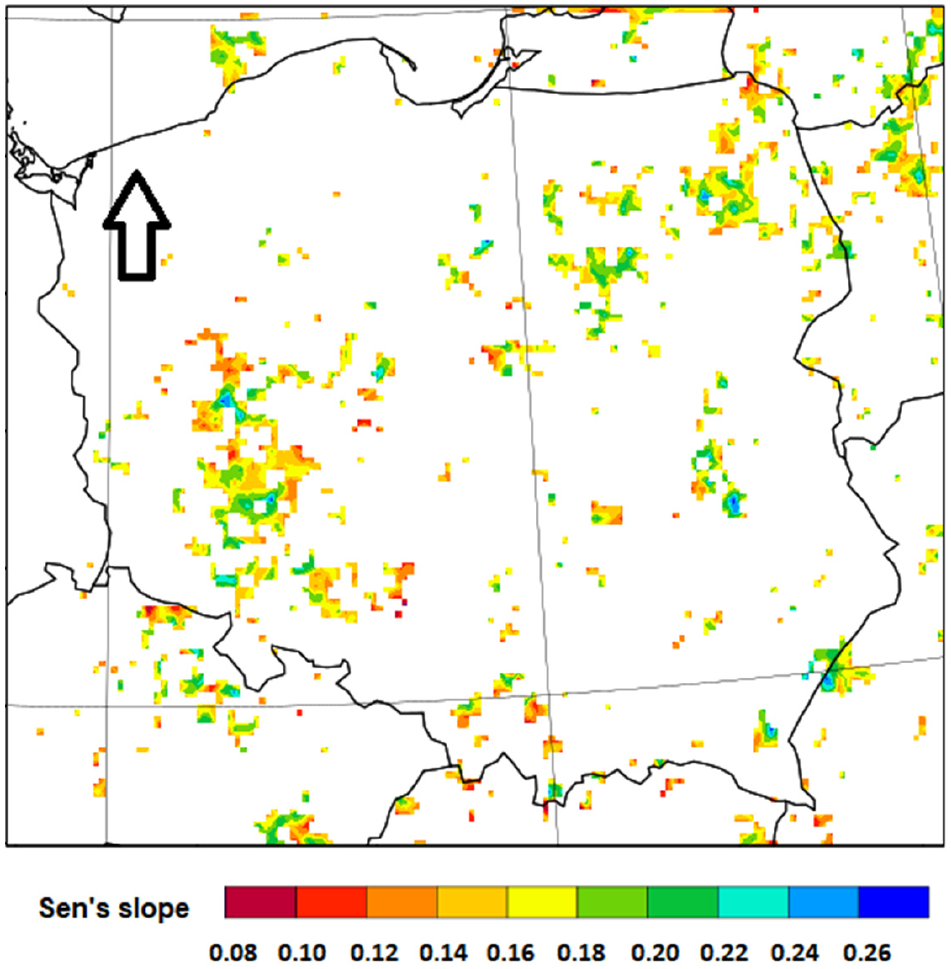
Figure 15. Sen’s slope for significant trends ( α = 0.05) of annual maximum value of PW. The arrow shows direction of changes of the annual maximum value of PW over the area of Poland without statistically significant trends.